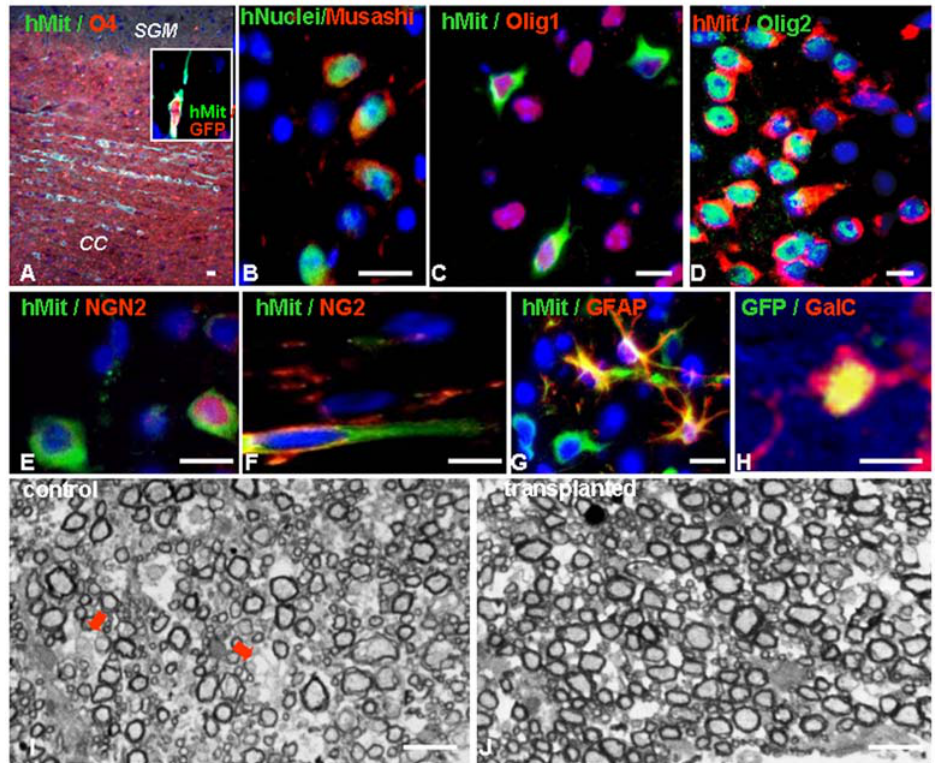
Figure 3. Transplanted NPs migrate into white matter tracts of EAE brains, differentiate into neural progenitors and do not promote remyelination. ( A–H ) Immunofluorescence stainings of brain sections demonstrating the migration and differentiation of transplanted NPs, which were identified by the expression of human mitochondria ( A , C–G ), human nuclear antigens ( B ) and GFP ( inset in A , H ). ( A ): The NPs migrated extensively into white matter areas of the CNS such as the corpus callosum ( CC ) and were not observed in grey areas such as subcortical grey matter ( SGM ). Co-staining against the oligodendroglial marker, O4 (red) was used to identify the white matter. ( B–H ): Most of the transplanted cells either remained as uncommitted NPs expressing Musashi (B) or differentiated into early neuronal/oligodendroglial progenitors expressing Olig1 (C) or Olig2 (D). Further differentiation into more committed neuronal progenitors, oligodendrocyte progenitors or astrocytes expressing NGN2 (E), NG2 (F) and GFAP (G), respectively, was infrequent ( , 1% of the transplanted cells per each of the cell types). Terminal differentiation of the transplanted NPs into GalC-expressing mature oligodendrocytes (H) was rare ( , 0.01% of the transplanted cells). Nuclei in A–H are counterstained with DAPI (blue). I–J : Toluidine blue stained transverse semi-thin sections of resin embedded spinal cords of NP-transplanted (J) and control (I) animals. In NP-transplanted animals, there were less demyelinated (arrows in I) and more normally myelinated axons than in controls. In both groups there were very rare remyelinated axons (G ratio . 0.8). Scale bars: 15 m m (A–H), 5 m m